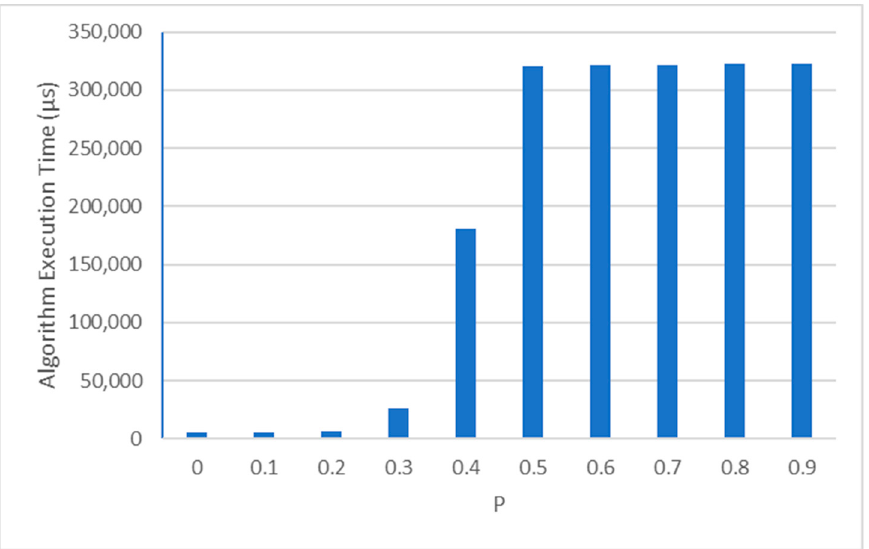
Figure 22. Execution time of fuzzy ring-overlapping range-free (FRORF) algorithm running in the